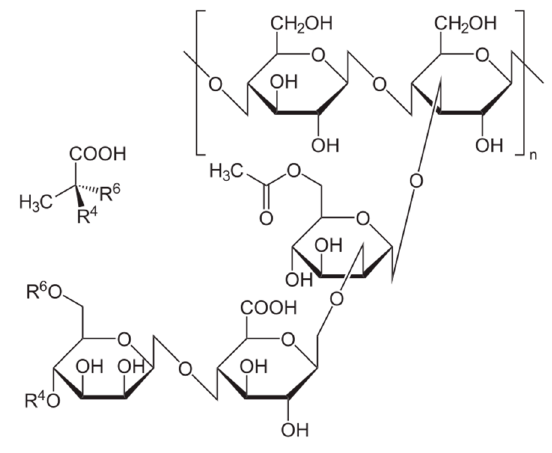
Figure 9. Chemical structure of xanthan.